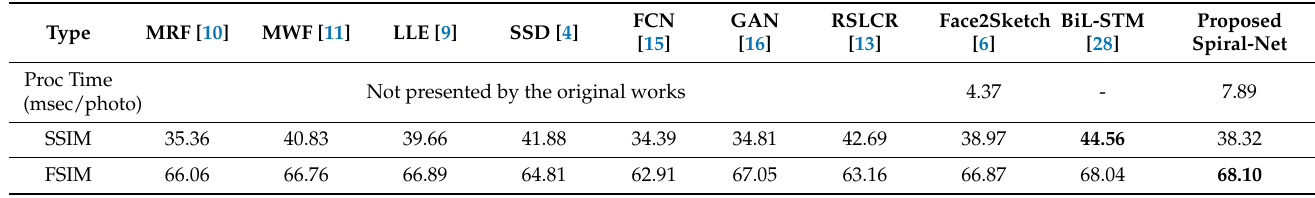
Table 6. Comparison of SSIM and FSIM Values for CUFSF.